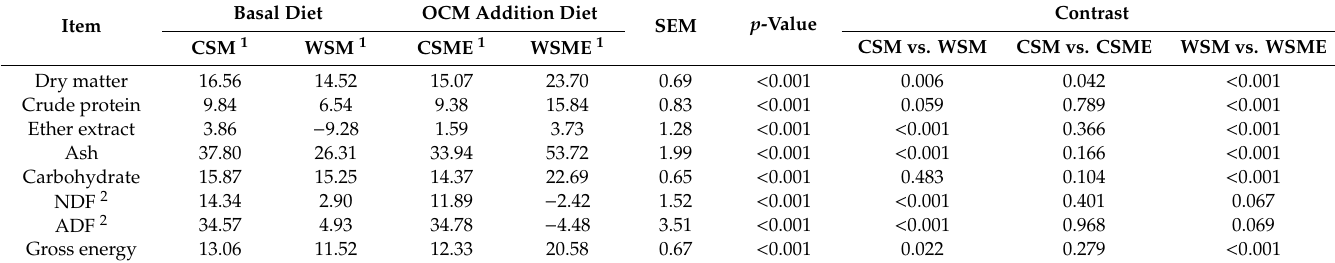
Table 6. E ff ects of the optimal carbohydrase mixtures on apparent hindgut disappearance of nutrients and energy in growing pigs fed two types of diets, %.